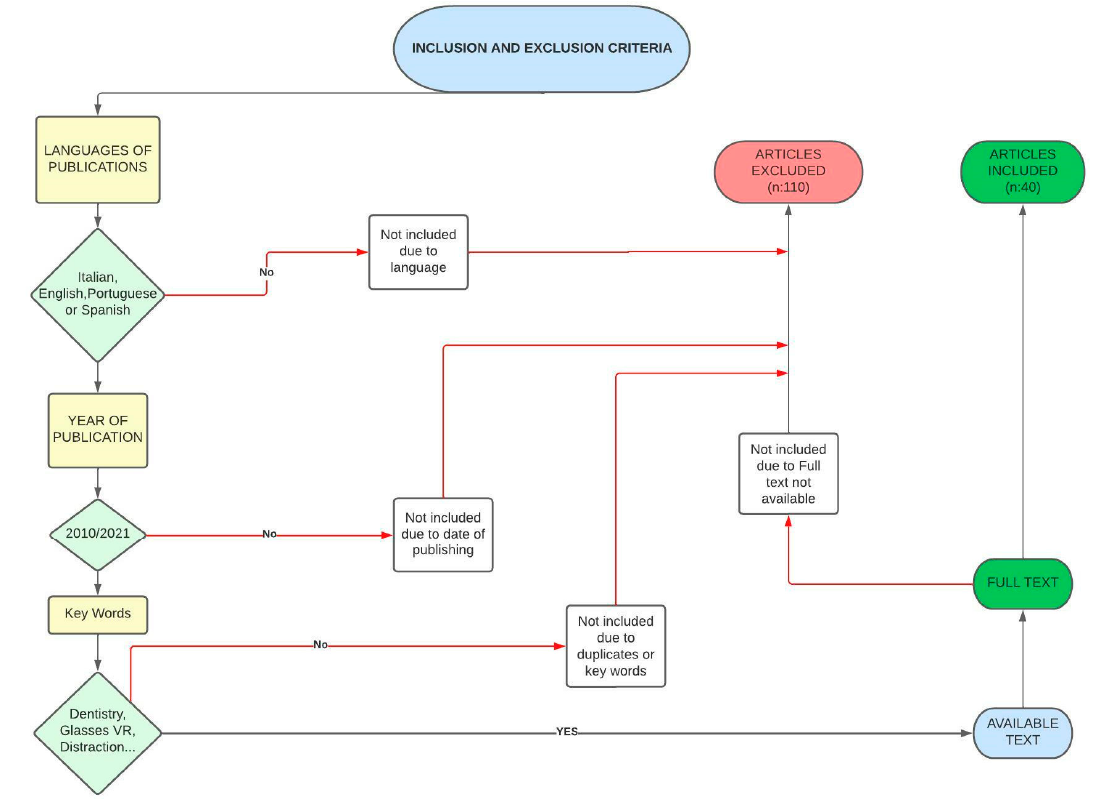
Figure 1. Flow chart and inclusion and exclusion